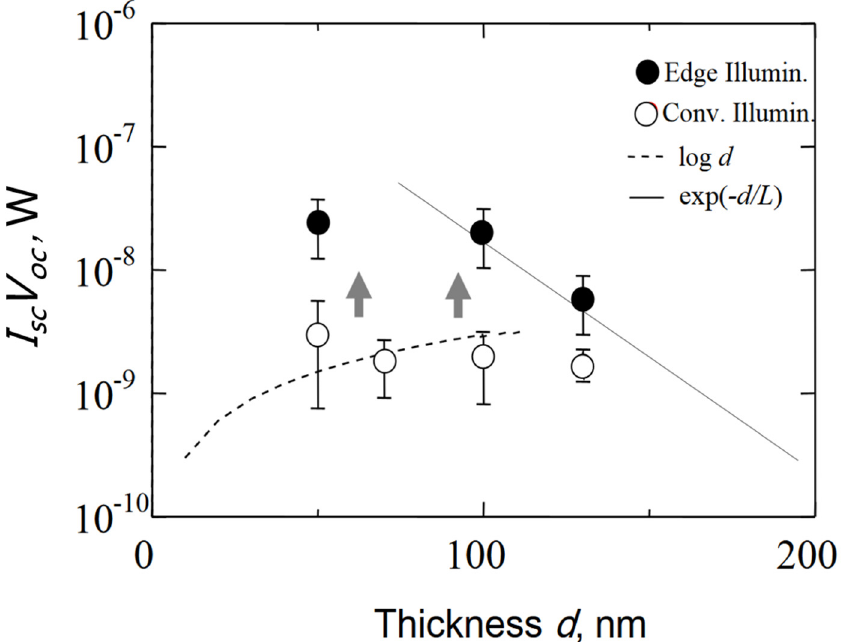
Figure 11. Conversion efficiency vs. active-layer thickness (or electrode spacing) d , under two different illumination configurations (Reproduced from [32], Engineering Research Publication, 2016).